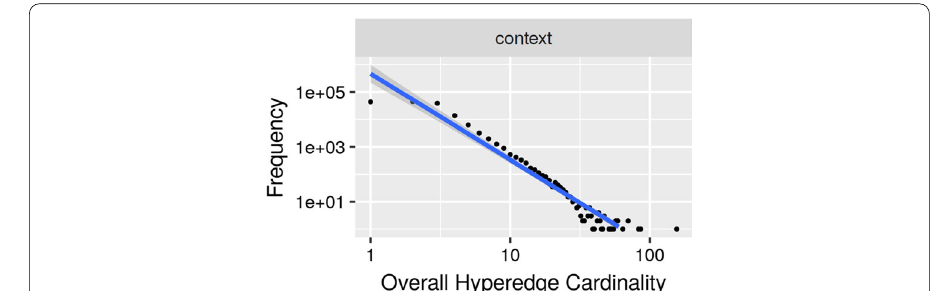
Fig. 18 Context hyperedge cardinality distribution (log–log scale)